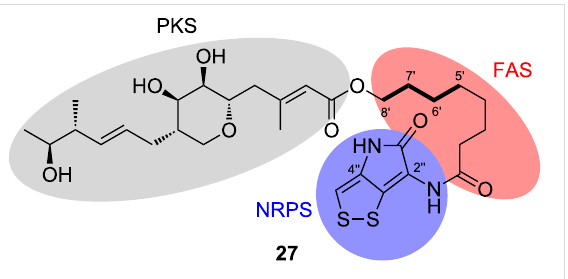
Figure 5: Structure of thiomarinol A ( 27 ). Bold bonds indicate carbon atoms derived from